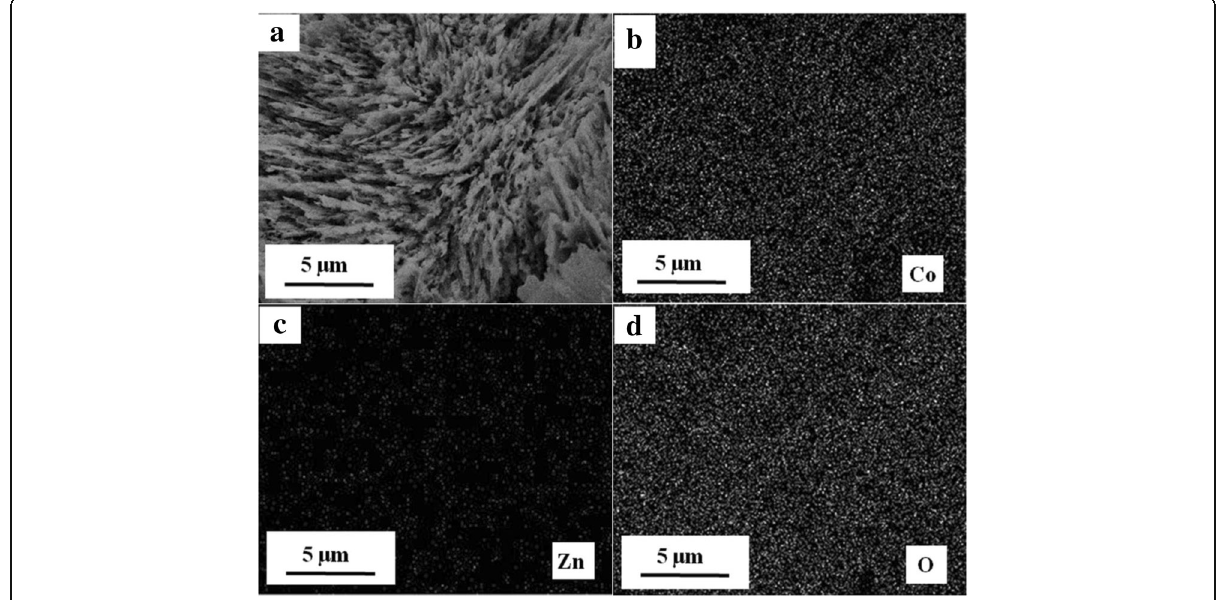
Fig. 8 a SEM image of Co 3 O 4 /ZnO-35 composite with EDX mappings of b Co, c Zn, and d O